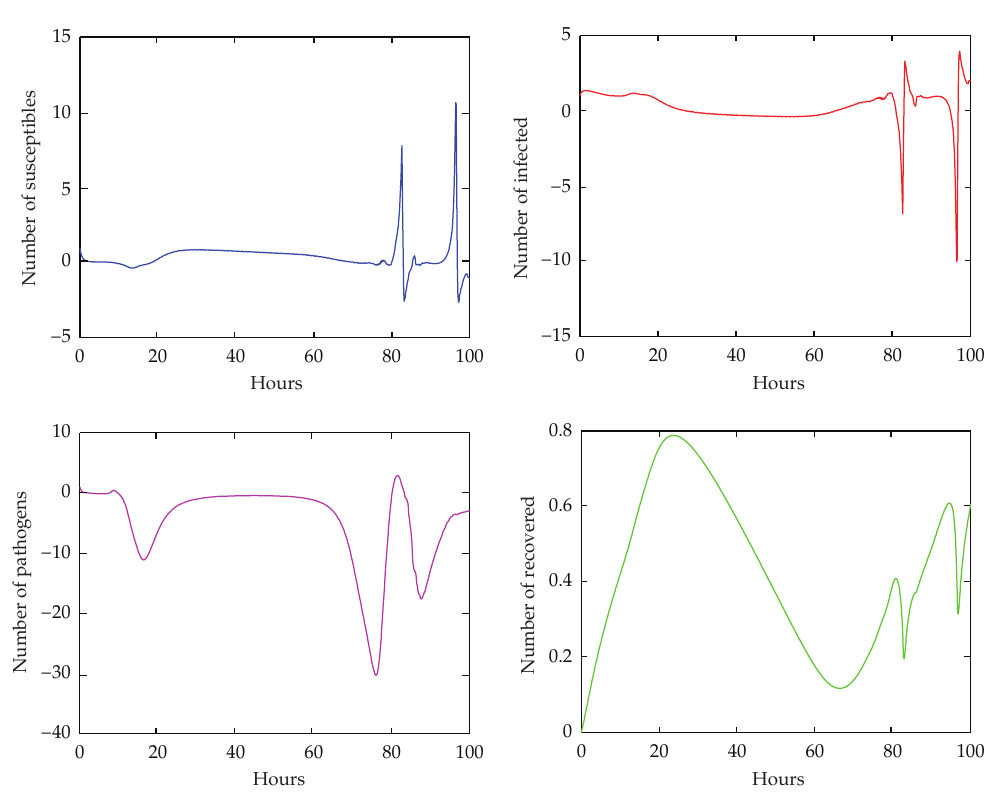
Figure 8: The e ff ect of optimal control with the number of susceptibles, infected individuals, pathogen con- centration, and the recovered individuals.